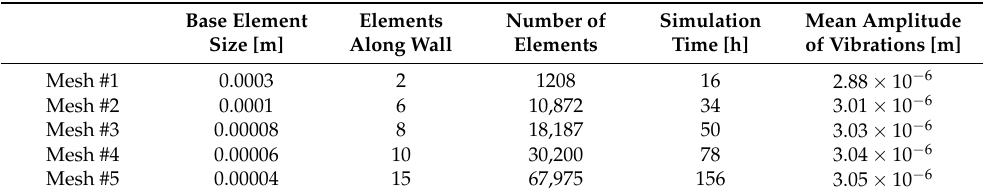
Table 3. Mesh parameters for finite element grid independence study with simulation time and mean amplitude of